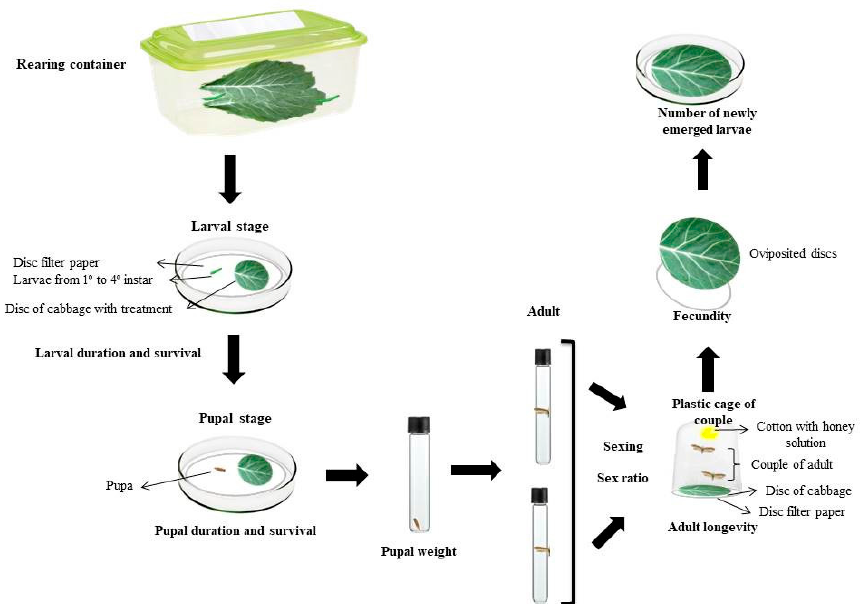
Figure 2. A schematic representation of the methodology used for the evaluation of the biological parameters of Plutella xylostella .